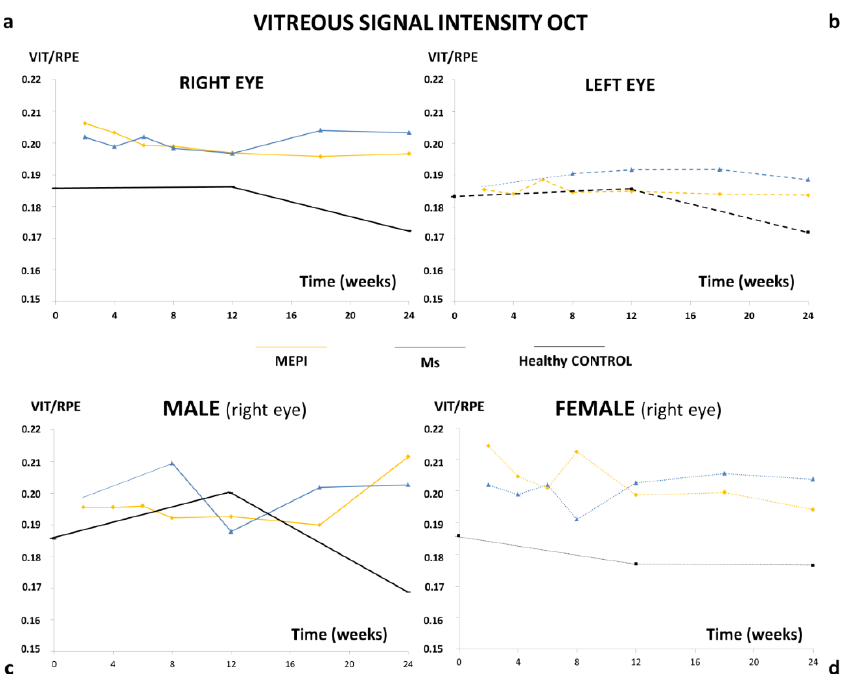
Figure 3. VIT/RPE signal intensity. ( a ) Right eye (both sexes); ( b ) left eye (both sexes); ( c ) males (right eye); ( d ) females (right eye). MEPI: episcleral vein sclerosis model (yellow); Ms: microsphere intraocular injection model (blue); healthy CONTROL: cohort of healthy animals without intervention (black); VIT: vitreous; RPE: retinal pigment epithelium.